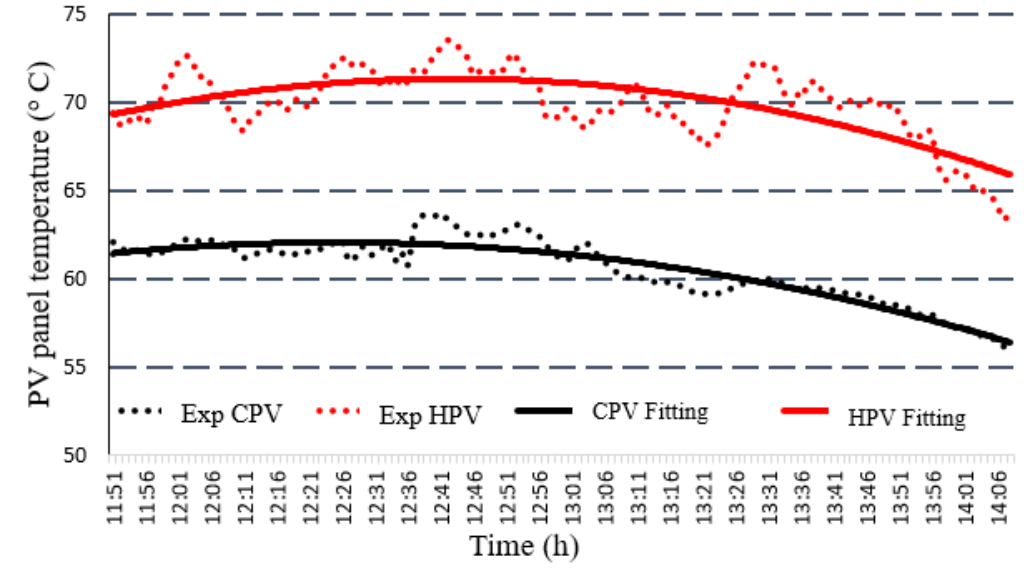
Figure 4. Temperature evolution of the cooled panel (CPV) and reference panel (HPV) at air flow rate = 0.01254 kg/s and water flow rate = 0.0083 kg/s.